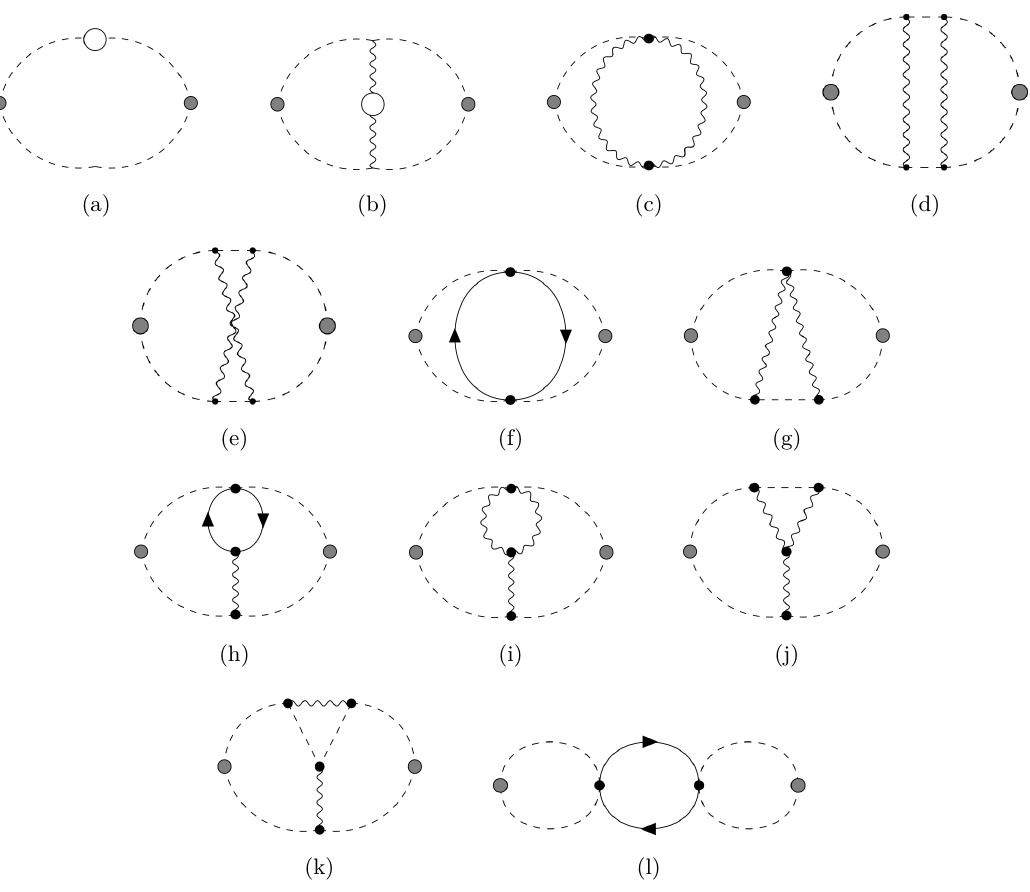
Figure 2 . Two-loop diagrams for the two-point function. In (a) the white circle is the two-loop correction to the scalar propagator, while in (b) the circle is the one-loop correction to the gauge field propagator. Diagrams (h), (i), (j) and (k) sum up to provide the vertex